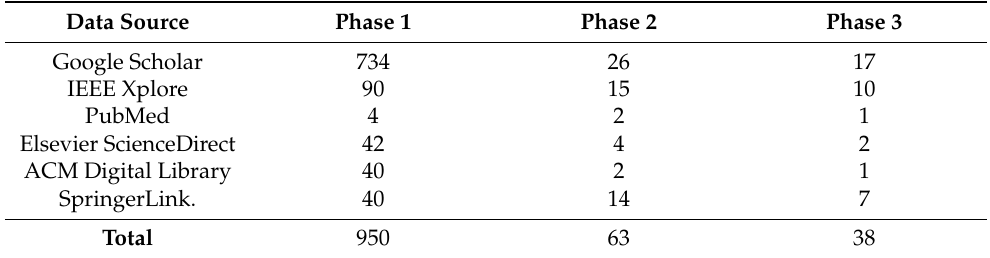
Table 1. The number of search results per database after applying the three selection